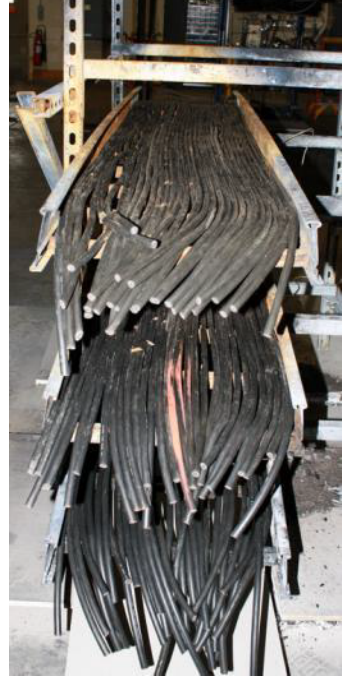
Figure 3. Photograph of the cable arrangement in MT3, taken from the CHRISTIFIRE report [15].